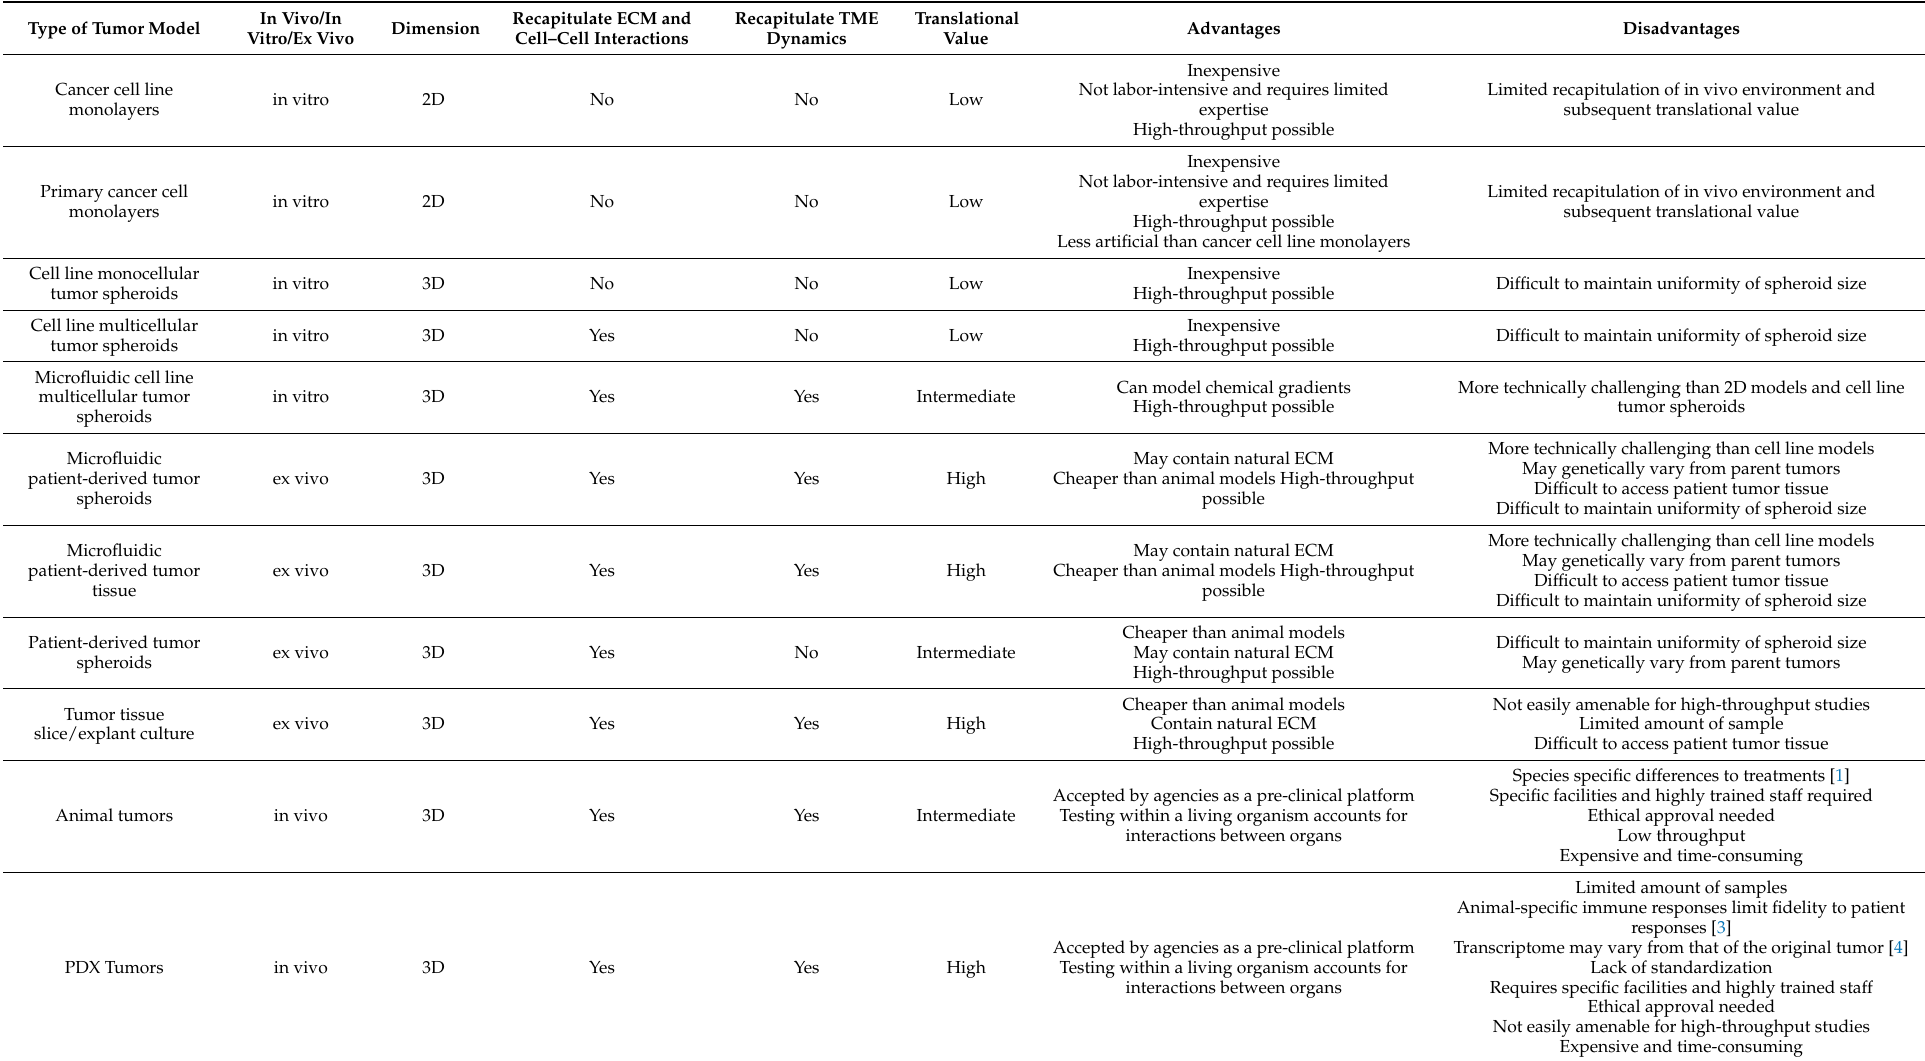
Table 1. Advantages and disadvantages of different tumor